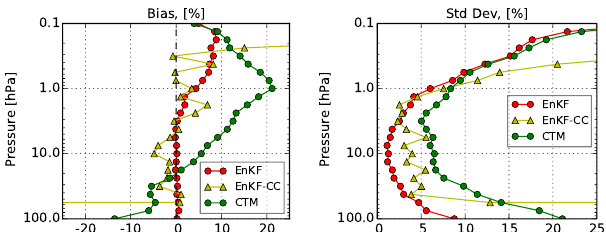
Figure 10. OmF bias (top) and standard deviation (bottom) between Aura-MLS data and O 3 analyses of EnKF (red), EnKF-CC (yellow) and CTM (green); see text for acronym definition. The statistics are computed during 24h on 15 September